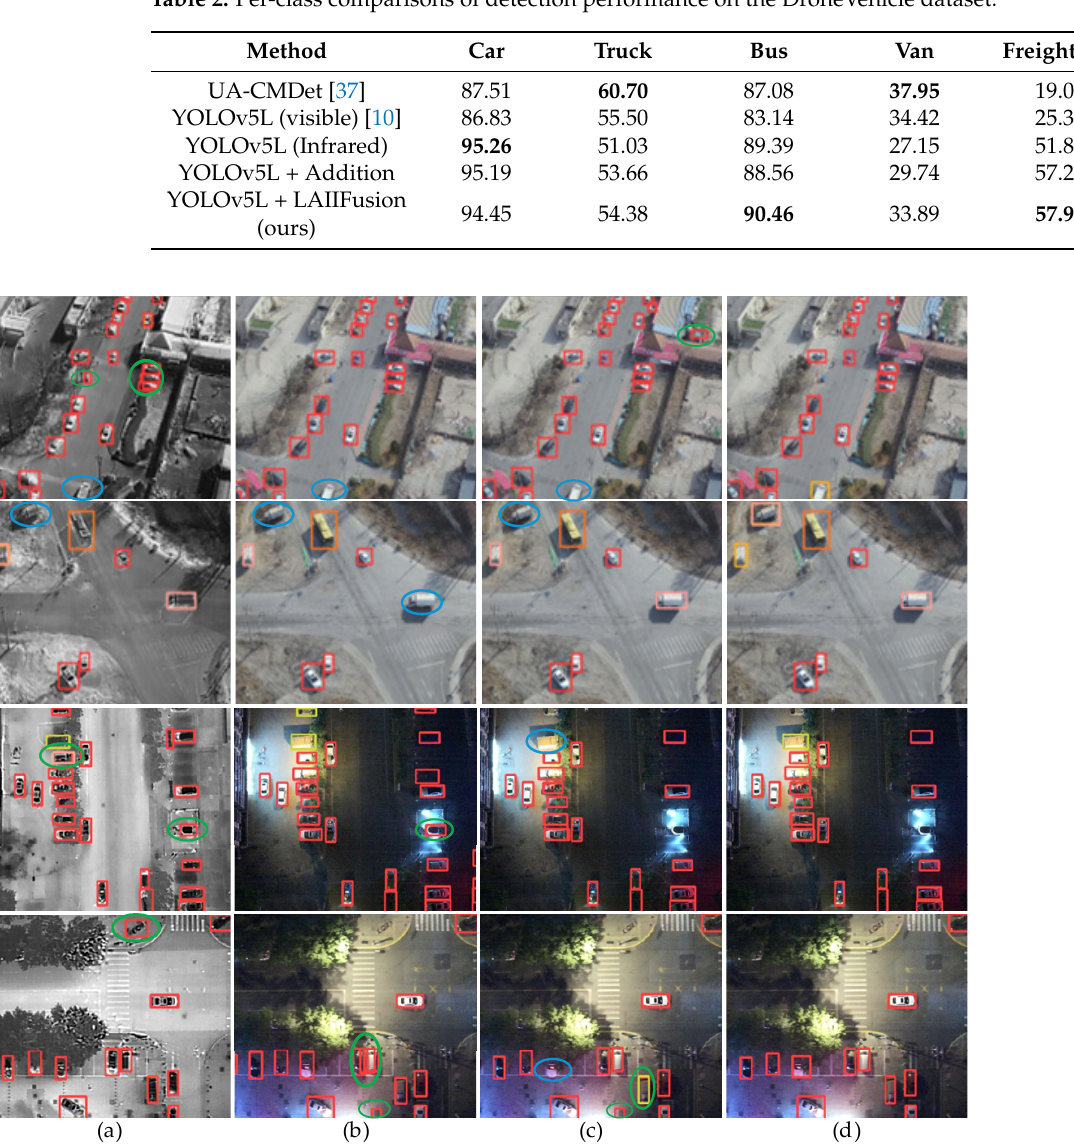
Table 1. Comparisons of detection performance on the DroneVehicle dataset.